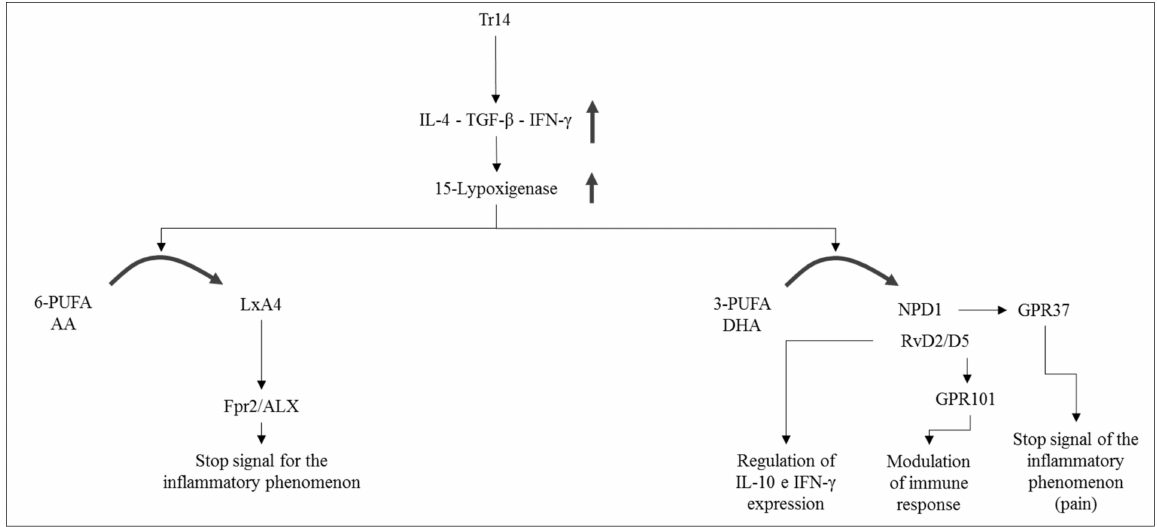
Figure 5. Interleukin-4, TGF-beta and IFN-gamma are physiological regulators of lipoxygenase expression and suggest an important link between 15-lipoxygenase function and the immune/inflammatory